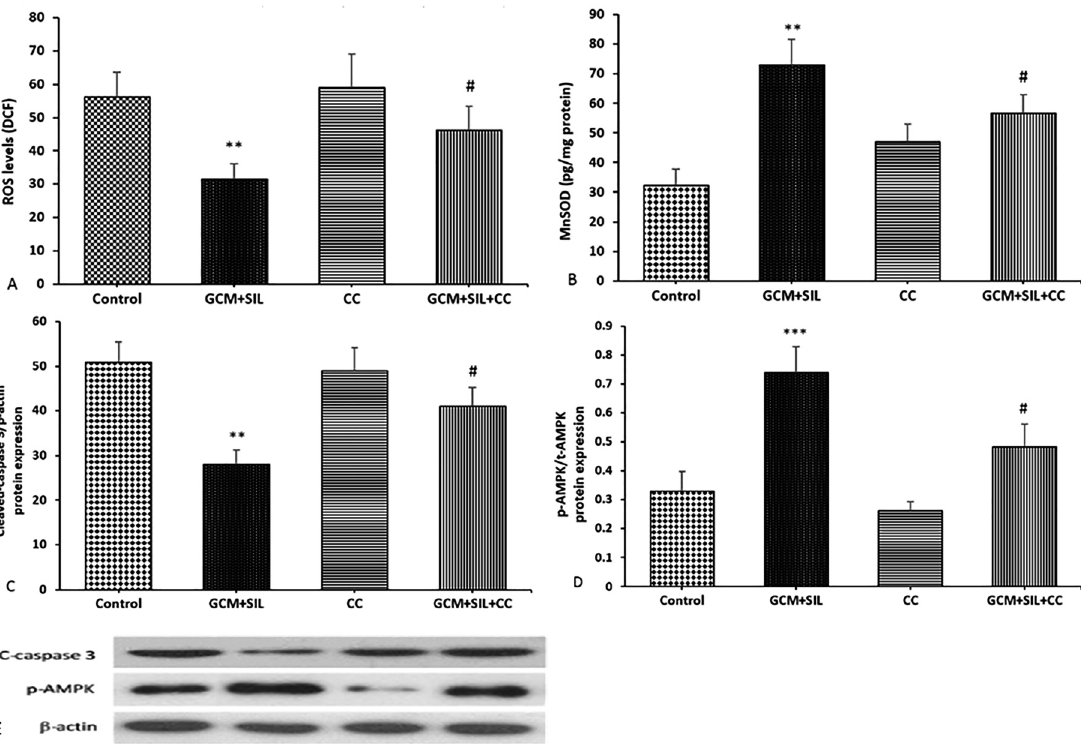
Figure 6: AMPK inhibition reversed the effect of combination therapy in H 2 O 2 -stimulated HepG2 cells. (A) ROS production; (B) MnSOD; (C) cleaved caspase 3; (D) p-AMPK; and (D) representative immunoblots. The data was expressed as mean ± SD. N=6for each group. **p<0.01 and ***p<0.001 as compared with Control group; and #p<0.05 as compared with GCM + SIL group. GCM, ginsenoside compound-Mc1; SIL, silibinin; HepG2, human hepatoma cell line; CC, compound